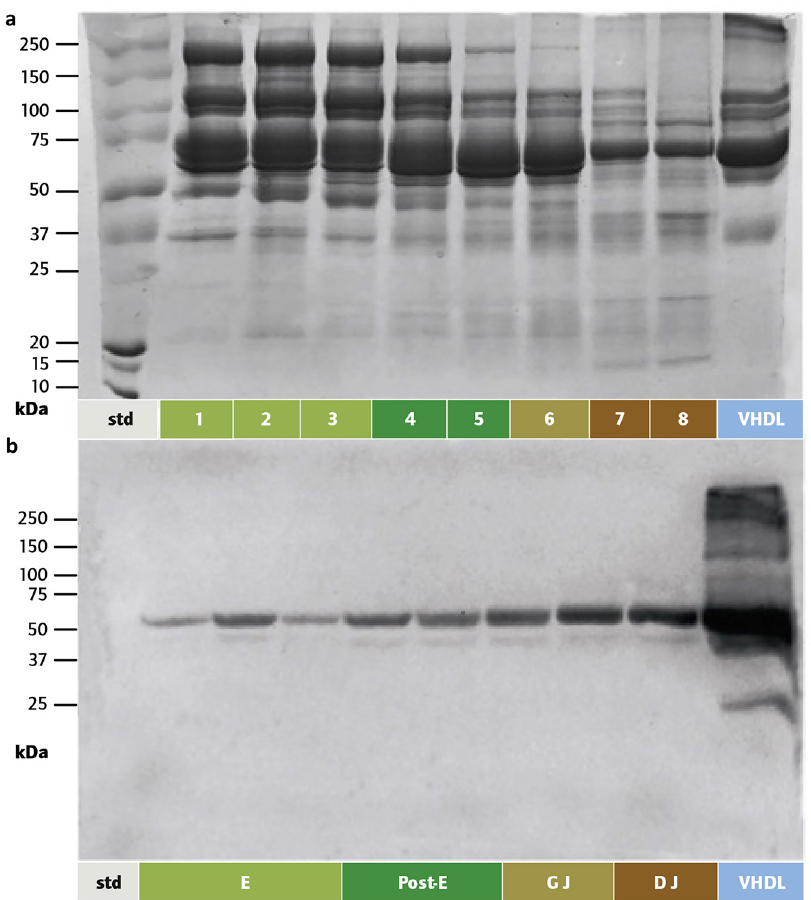
Figure 4. Analysis of soluble proteins during P. pythagoricus development. Electrophoresis (SDS-PAGE): 20 μg of soluble proteins per well (a) and immunoblotting with anti-Hc polyclonal antibodies: 15 μg of soluble proteins per well (b). std: molecular weight standard lipoprotein of P. pythagoricus ; development. Numbers with the